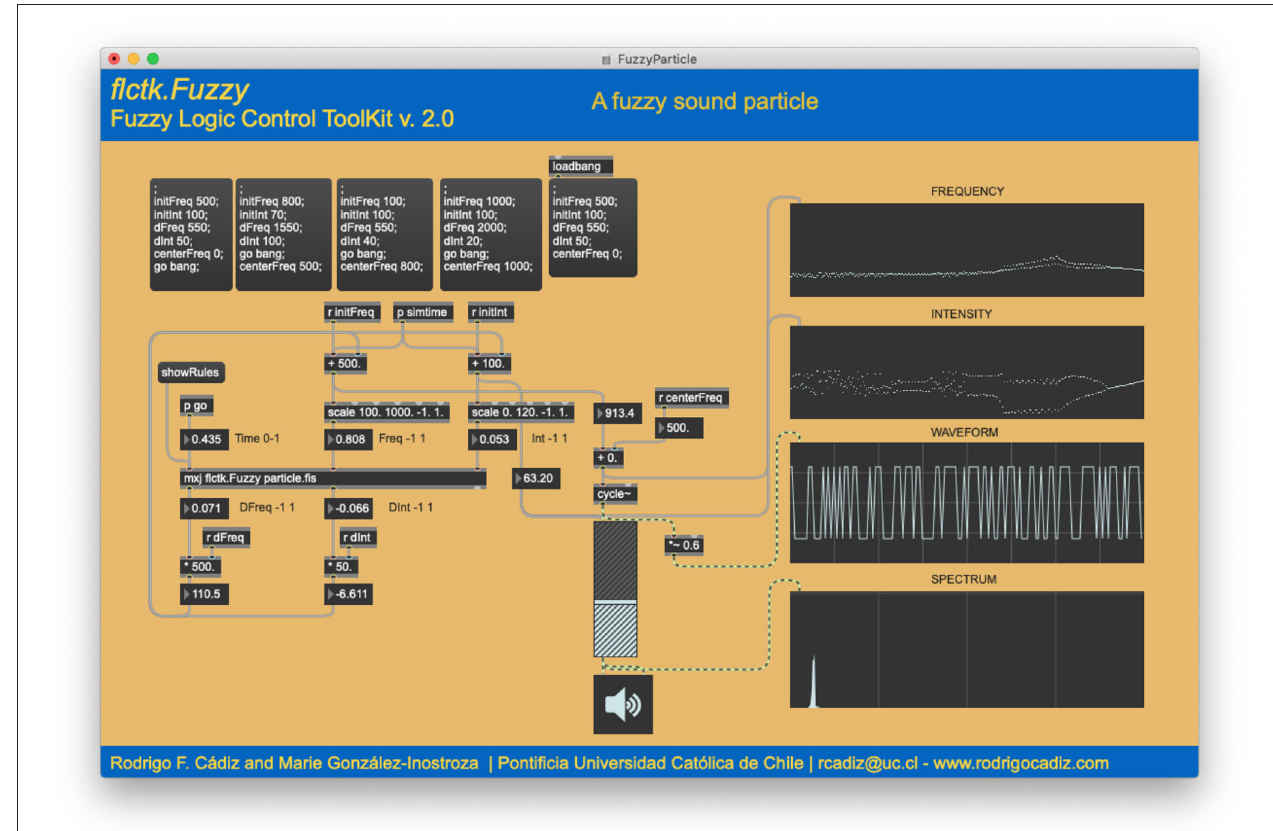
FIGURE 5 | Particle sound synthesis example. In this case the fuzzy system is dependent on time. As time progresses in a linear fashion, the output variables frequency and intensity exhibit a highly non-linear behavior.